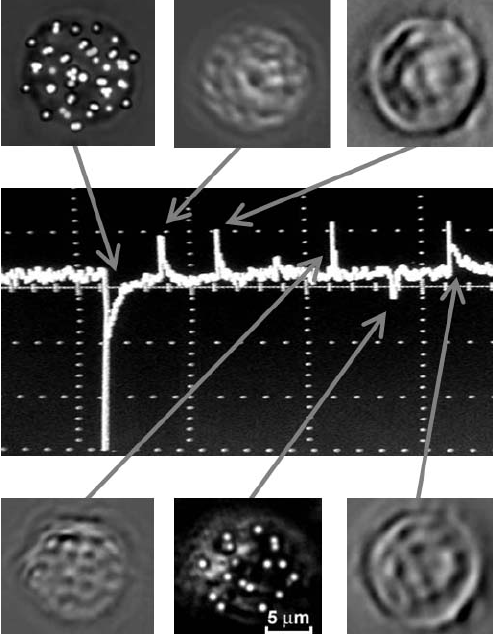
Figure 27. Middle, Tracings of the PT signals (time scale, 200 ms/div) from leukemia cells. Top and bottom, Corresponding PT images. OPO parameters: wavelength, 530 nm; pulse rate, 100 Hz; fluence, 100 mJ/cm 2